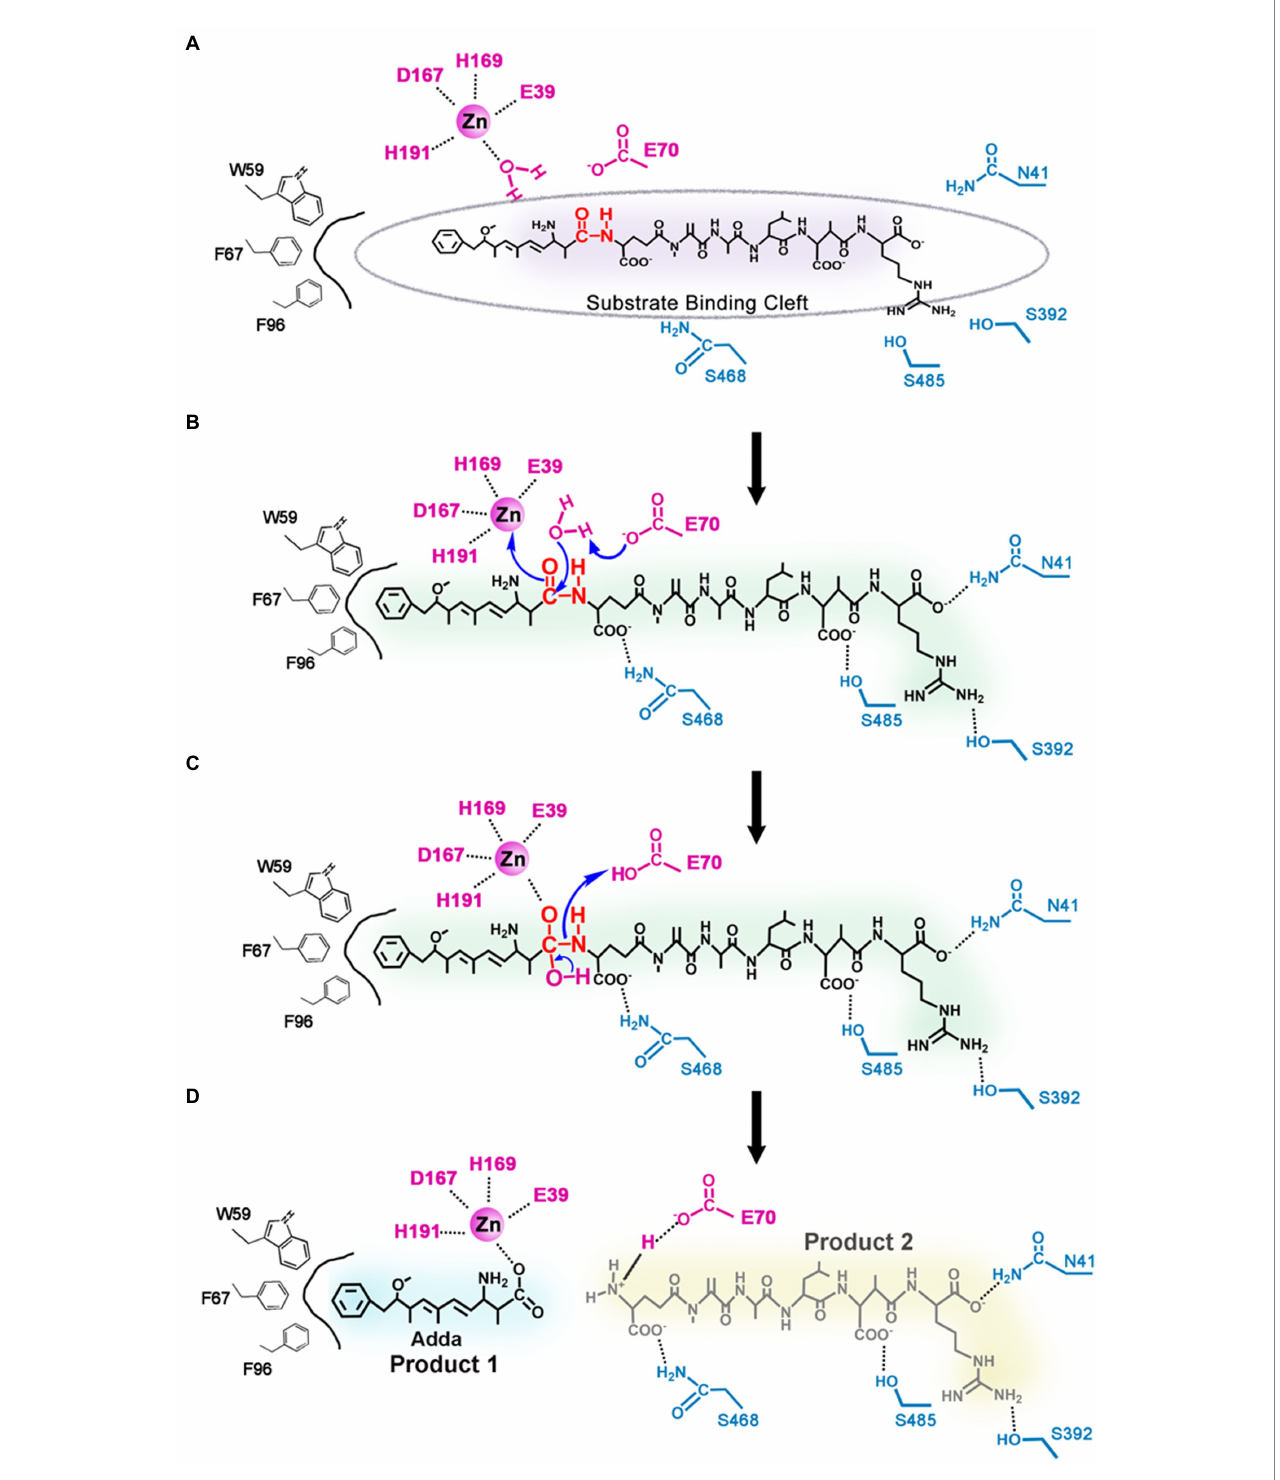
FIGURE 4 Proposed catalytic mechanism of linearized MC-LR biodegradation by MlrC. (A) The MlrC active center is composed of the catalytic site (the zinc ion, one water molecule, and the residues E39, D167, H169, and H191) and the substrate-binding site (the residues E70, W59, F67, F96, N41, S392, S485, and S468); (B) Residue E70 as a general base catalyst removing a proton of the metal-bound water to form zinc-OH-nucleophile for attacking the amide bond of the substrate. (C) E70 as a general acid catalyst donating a proton to the amine. (D) Two products of linearized MC-LR biodegradation by